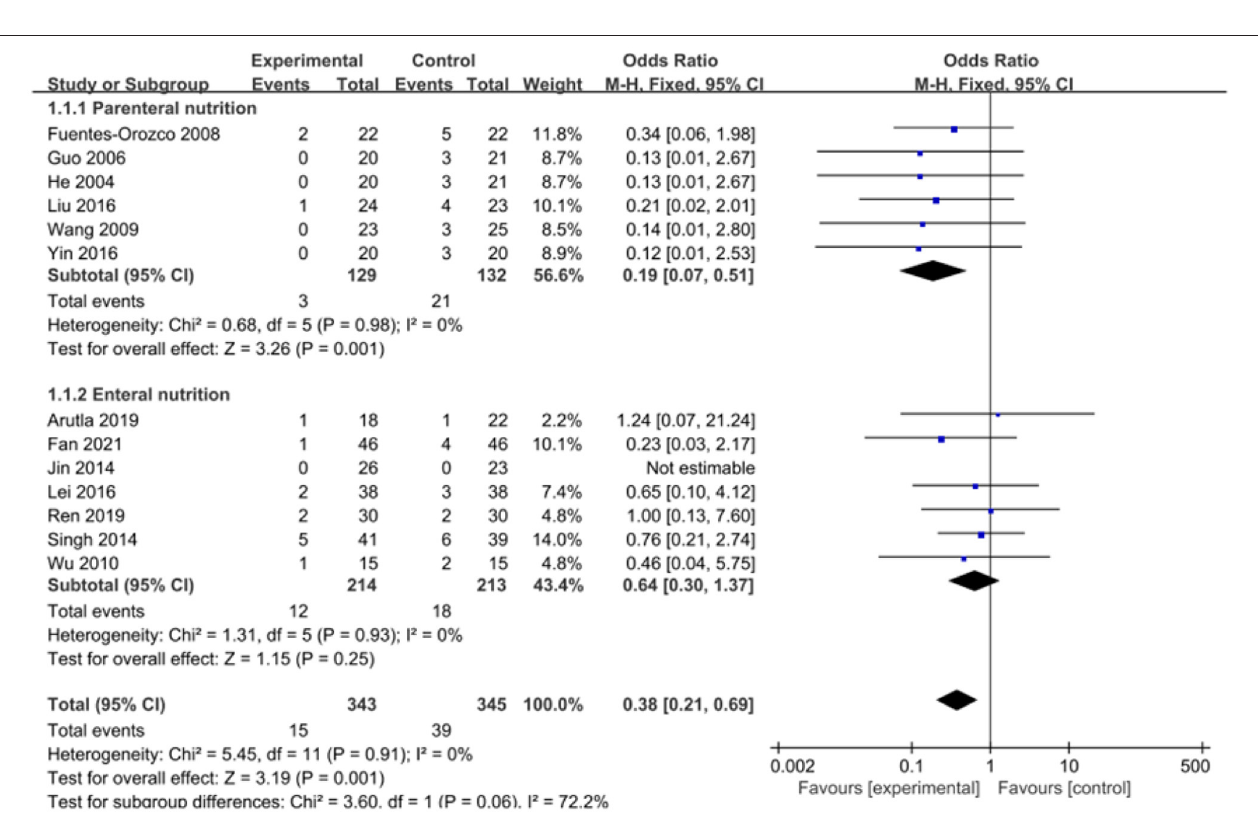
FIGURE 3 | Risk of bias